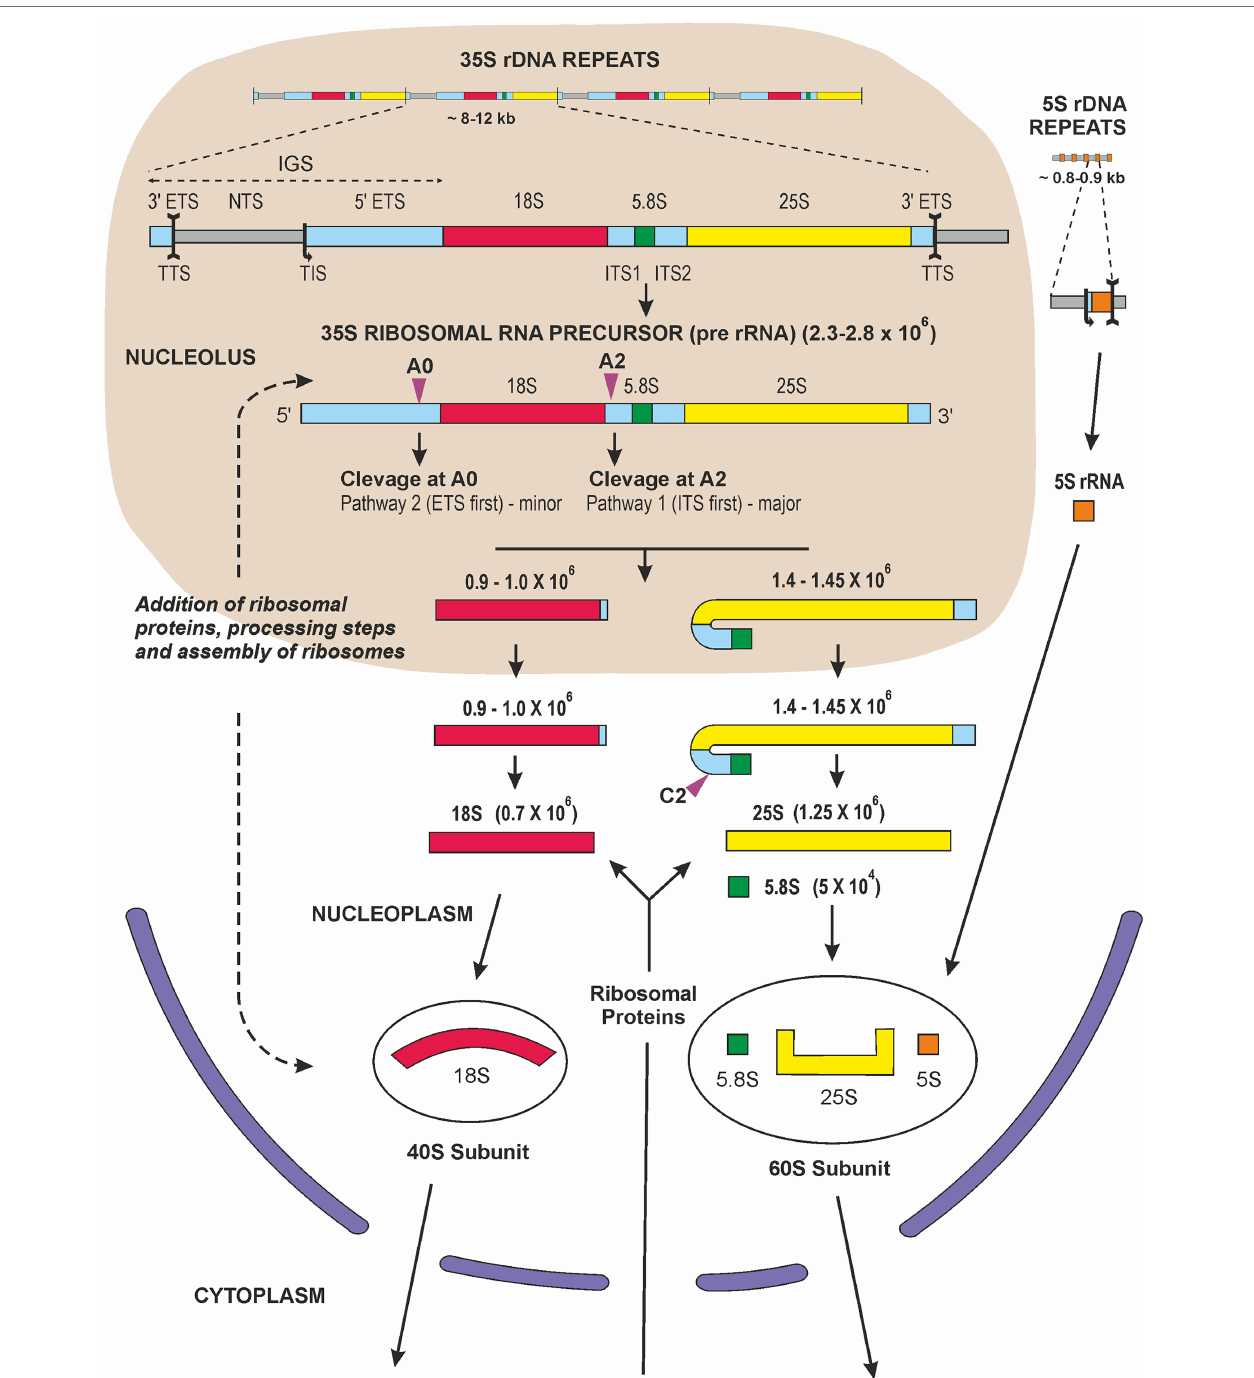
FIGURE 2 | Graphic representation of ribosome biogenesis in eukaryotic cells (adapted from (Grierson, 1984; Sáez-Vásquez and Delseny, 2019). Transcription of rDNA requires RNA Pol I activity and a subset of general transcription factors. The primary transcript, precursor-rRNA (35S in plants and yeast or 45S in mammals), encodes three rRNAs and is first co-transcriptionally processed into the mature 18S, 5.8S, and 25S/28S rRNA. This processing steps involve multiple endonucleolytic and exonucleolytic cleavages (violet arrowheads) occurring in the nucleolus [A0 site or P site according to nomenclature of (Sáez-Vásquez and Delseny, 2019)], A2 site and the nucleoplasm (C2). The 18S rRNAs assemble with ribosomal proteins of the small 40S ribosomal subunit, RPSs, while 5.8S, 25S/28S and 5S rRNA assemble with ribosomal proteins, RPLs, forming the large 60S ribosomal subunit. The 5S rRNA is transcribed in the nucleoplasm by RNA Pol III and imported into the nucleolus. Assembly and transport of ribosomal particles from nucleolus to cytoplasm requires hundreds of specific 40S and 60S RBFs (Ribosome Biogenesis Factors). The 40S and 60S ribosomal subunits finally join to form translationally competent ribosomes in the cytoplasm. Sizes of individual rRNA molecules are in